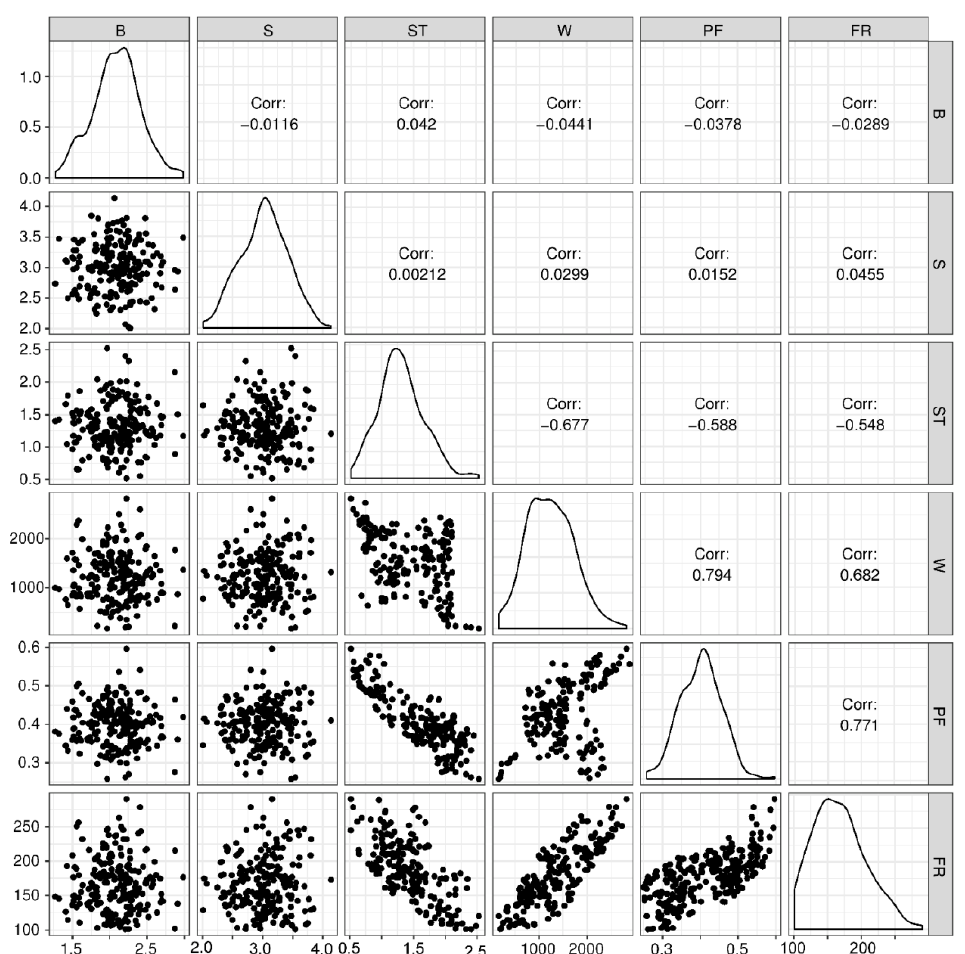
Figure 3. Matrix of the attributes used in the fly-rock database.